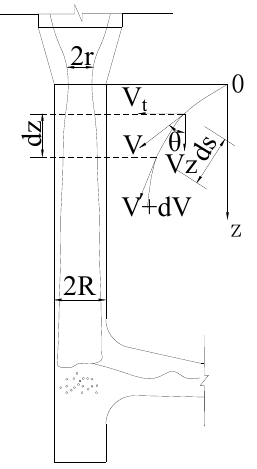
Figure 10. Diagram of the average velocity in the shaft section.